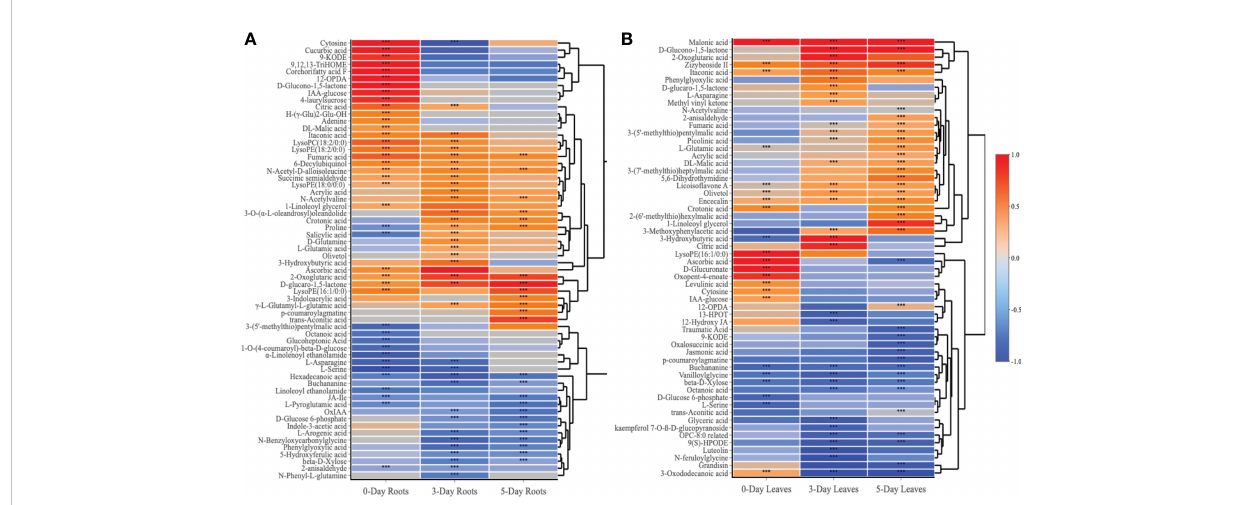
FIGURE 6 Heatmap analysis of metabolites that altered in roots (A) and leaves (B) at day 0, day 3 and day 5 following the SWE treatment. Log 2 FC data were used to represent the up (red color) or down (blue color) accumulation of compounds. The asterisks indicate signi fi cant differences (t-test and p- value <0.05) between the treated and the control